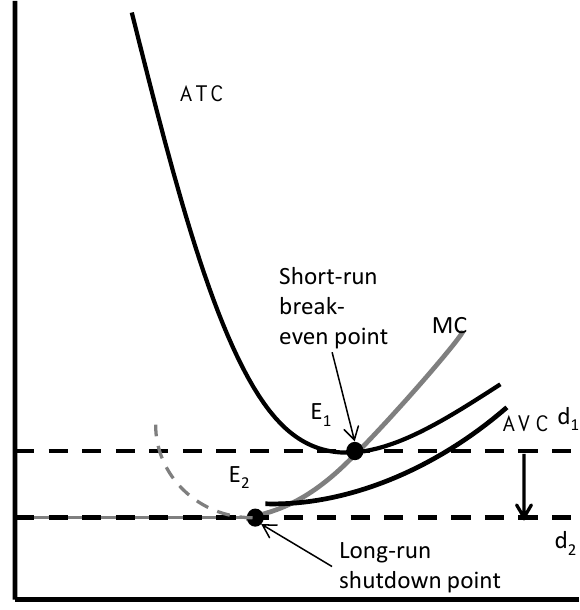
Figure 1. Cost curves for a single uranium